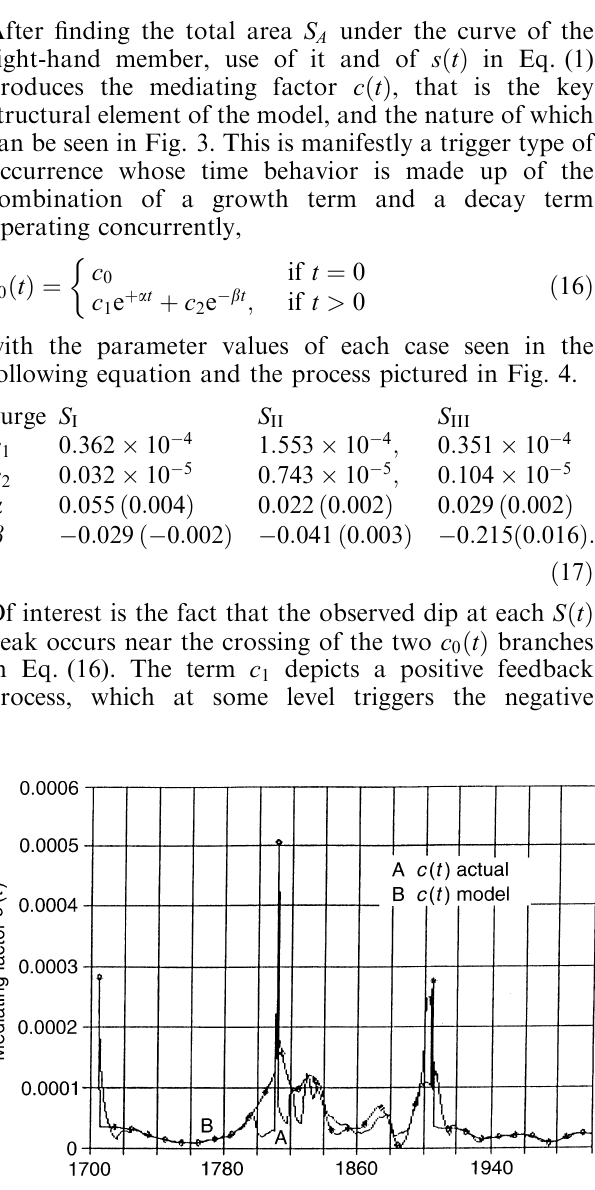
Fig. 3. Mediating factor (actual and model)